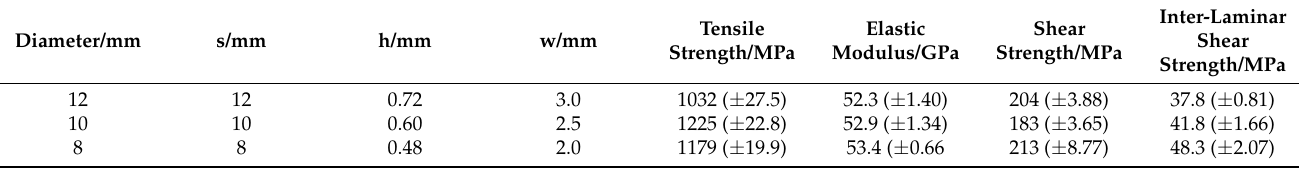
Figure 2. Typical BFRP connector. Table 2. Mechanical properties of BFRP